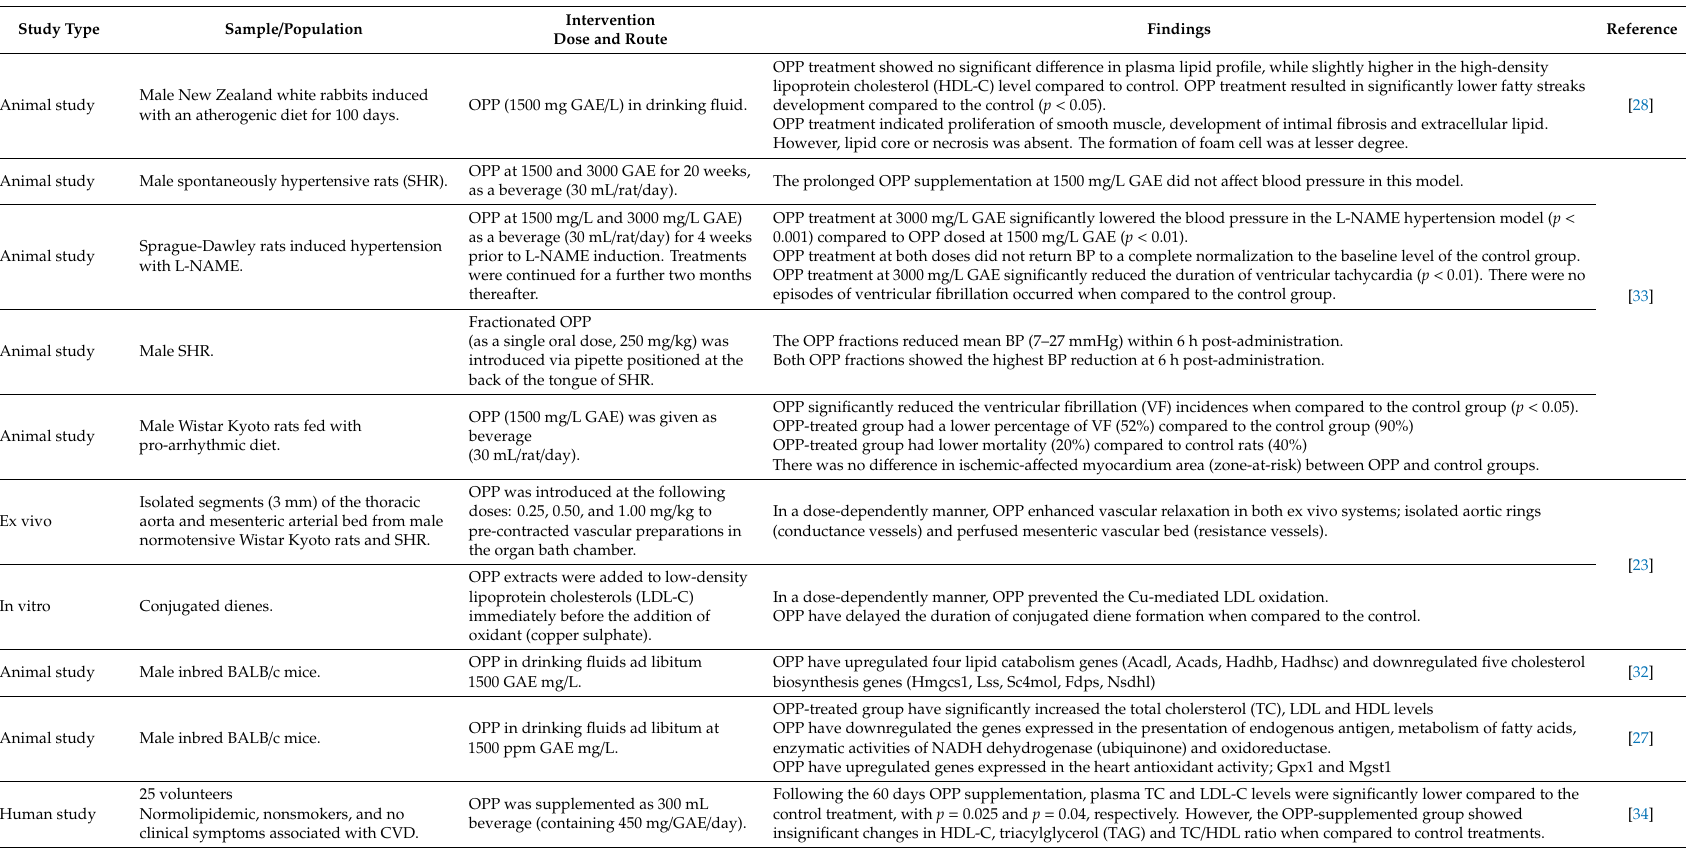
Table 1. The e ff ects of oil palm phenolics (OPP) in cardiovascular